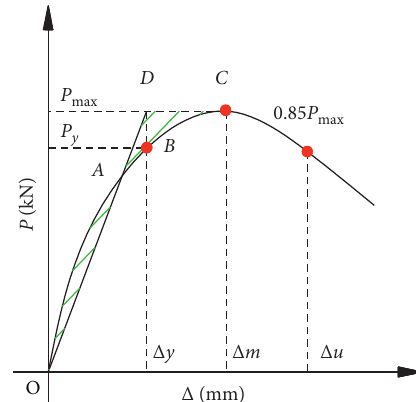
Figure 9: Calculation of characteristic points for each specimen. P is the yield load; P ma x is the peak